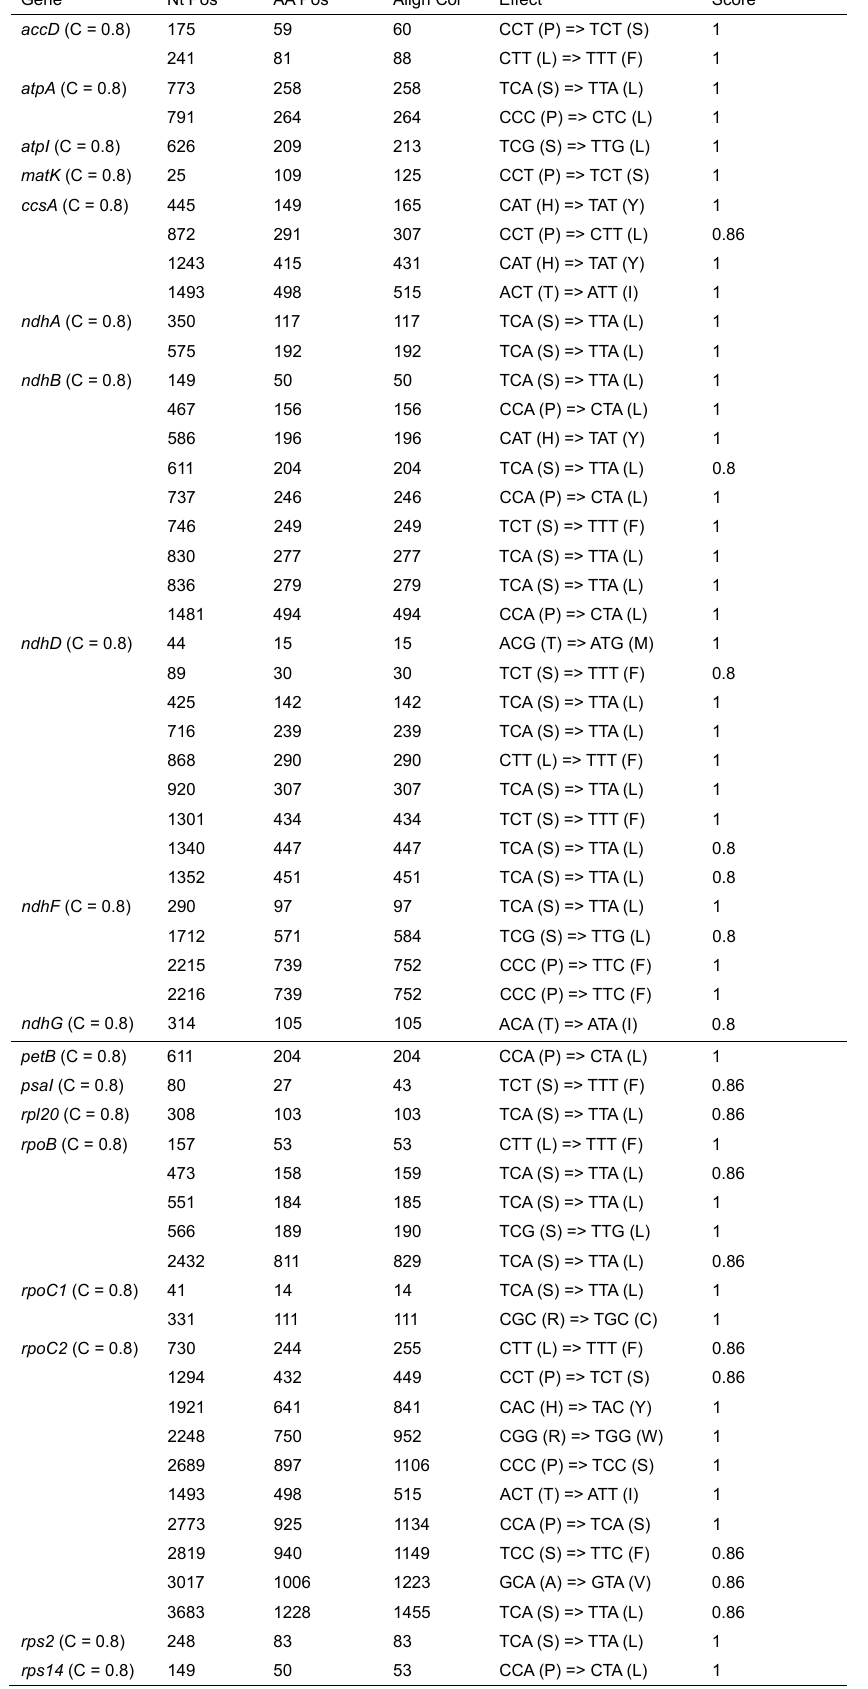
Supplement Figure 1 Comparison of the plastomes in Gentiana genus by using mVISTA. The genes are represented as gray arrows on the top of the alignments. The different regions